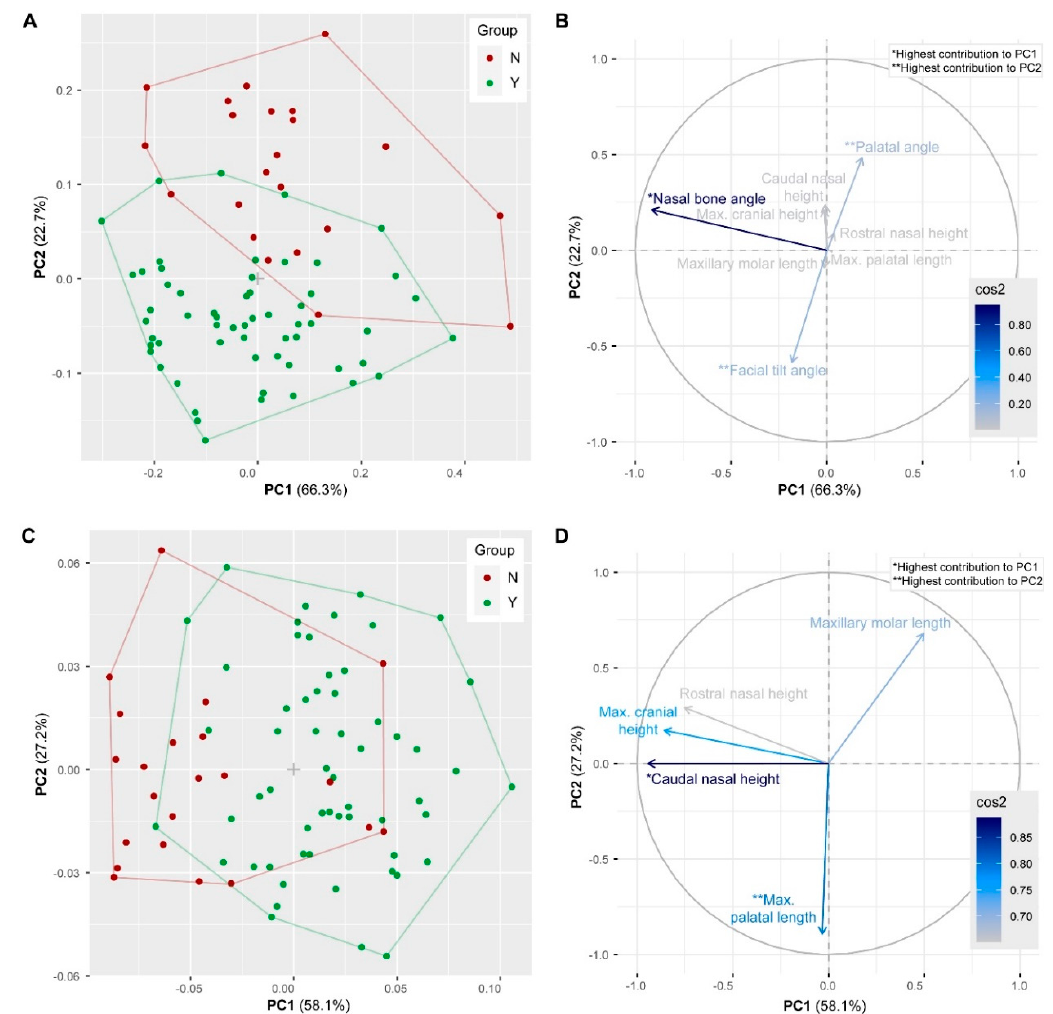
Figure 3. Results of the principal components (PC) analyses. ( A , B ) Scatterplot and contributions of the variables considering all measurements. ( C , D ) Scatterplot and contributions of the variables considering linear measurements only. The percentage of explained variances by each PC is indicated in parentheses. Arrows represent the squared loadings of the variables and the color intensity is proportional to the value of the loading. Variables that are closer to the correlation circle contribute more to the principal components.